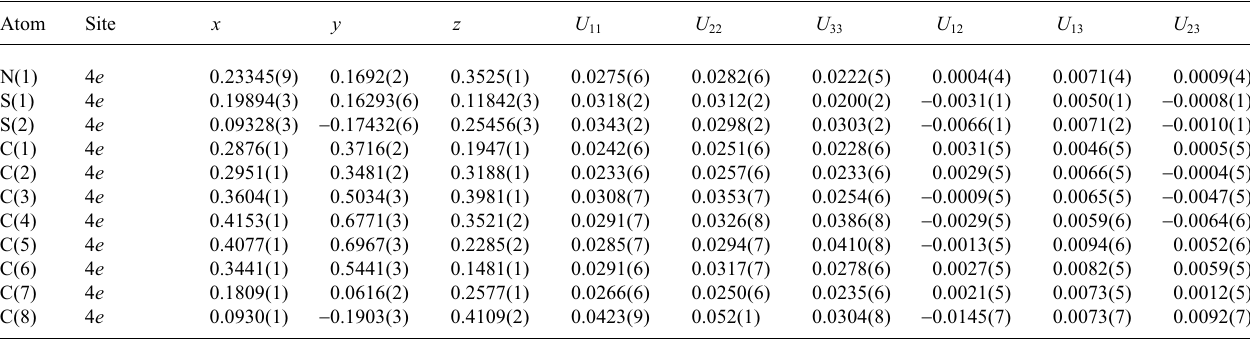
Table 3. Atomic coordinates and displacement parameters (in Å 2 )